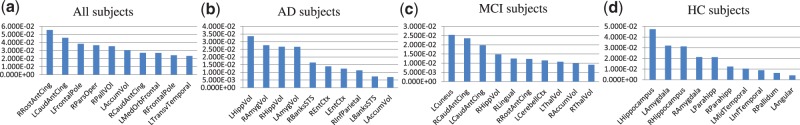
Top 10 FreeSurfer markers identified for rs11136000-CLU